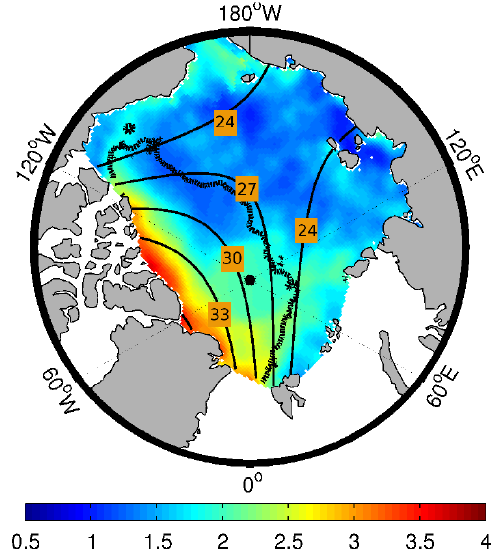
Fig. 1. Arctic sea ice properties and the Arctic sea ice area as defined in this study. Annual mean sea ice thickness from ICESat is shown in colour (m). The line of 50% multi-year ice fraction is plotted as a thick contour line. Both parameters are given as the average during the 2005–2007 ICESat campaigns. Climatological winter (October– April) snow depth from Warren (1999) from 1954 to 1991 is given as the labelled thin contour lines in